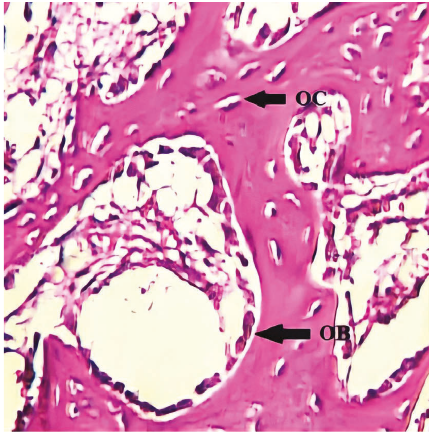
Figure 2: A view of the defect site in the GS group shows OB rimming newly formed trabeculae after 2-weeks. H&E